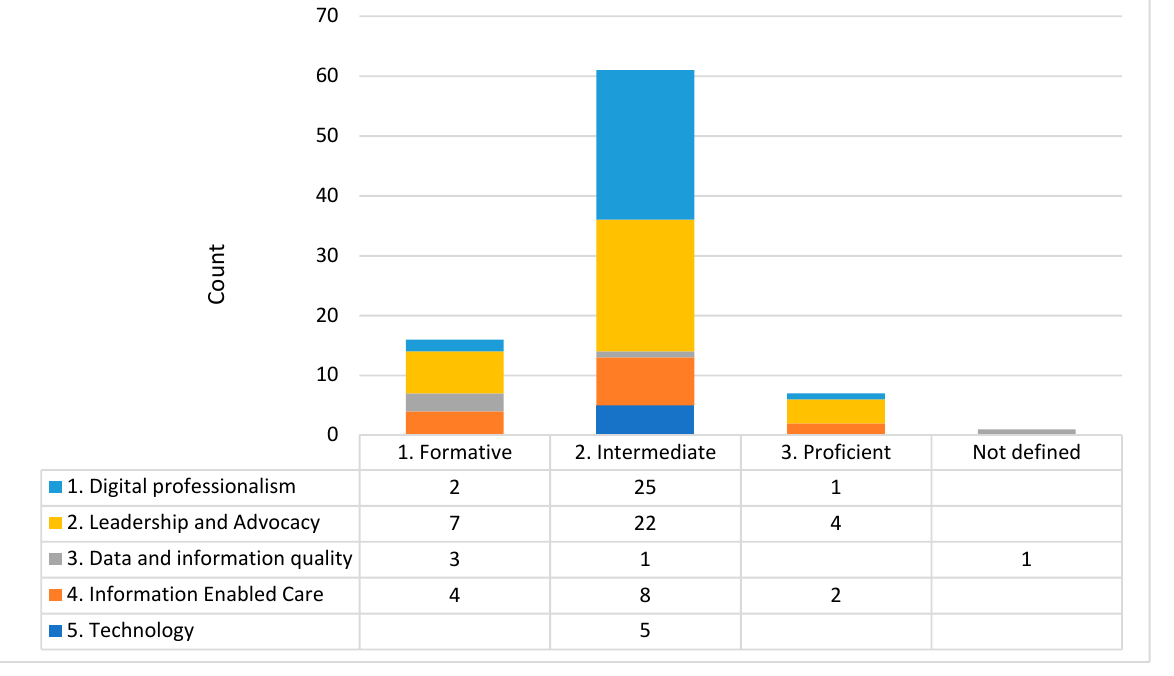
Figure 2. Histogram of self-rated digital capability for the nursing and midwifery workforce. NB each number represents the number of times (counts) the domain and level were mentioned in the focus groups.